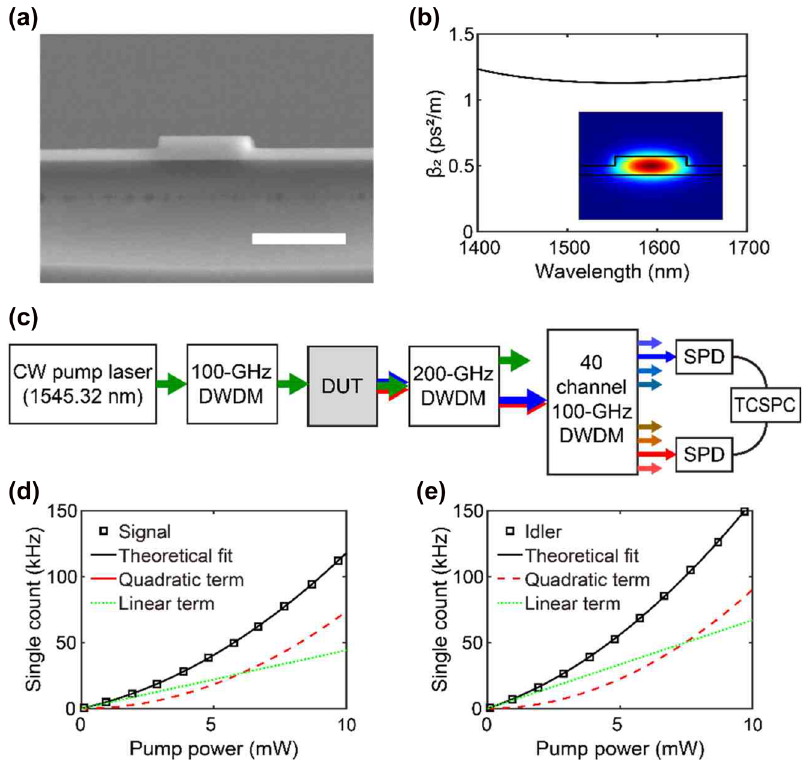
Figure 1: (a) Cross-sectional scanning electron microscope image of a fabricated waveguide. The scale bar is 1 μ m. (b) Group velocity dispersion of the fabricated waveguide against wavelength. The lower right inset is the computed electric field profile of the optical transverse-electric-like mode. (c) Schematic diagram of the apparatus used to measure the properties of generated photon pairs. Components of the apparatus are labeled as follows: CW, continuous wave; DWDM, dense wavelength division multiplexing; DUT, device under test; SPD, single-photon detector; TCSPC, time-correlated single-photon counting circuits. (d) Measured single counts of signal photons against pump power. (e) Measured single counts of idler photons against pump power. The black squares in (d) and (e) are the experimental data, and the solid black lines are quadratic fittings of measured data. The dashed red and dotted green lines represent the quadratic and linear contributions of the fitting functions,